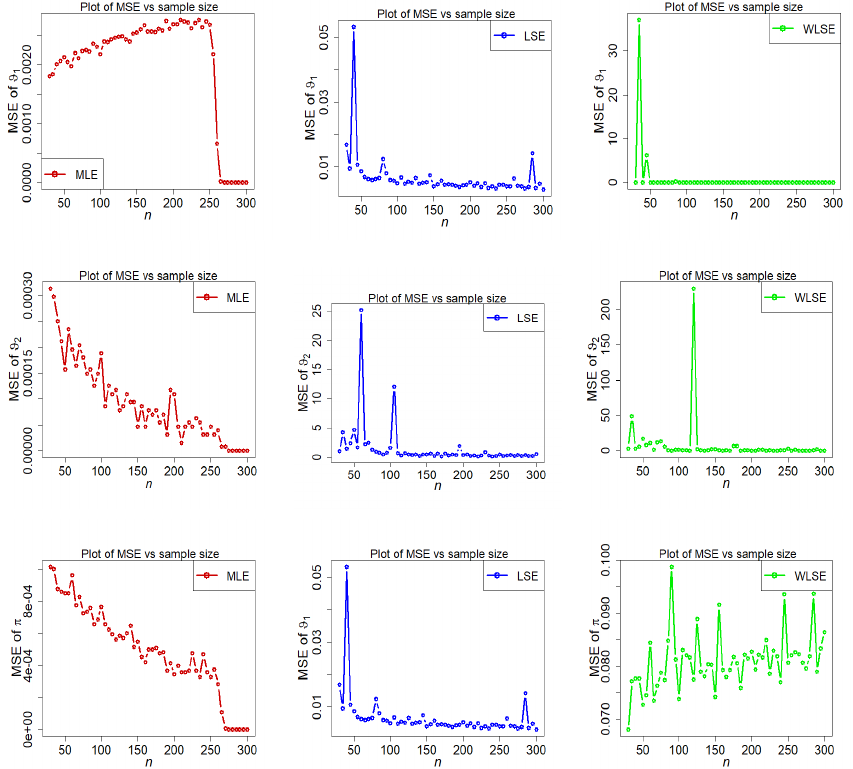
Fig. 8. Fluctuations of MSE of estimators under di⁄erent methods for parametric set I. Figure 8. Fluctuations of MSE of estimators under different methods for parametric set